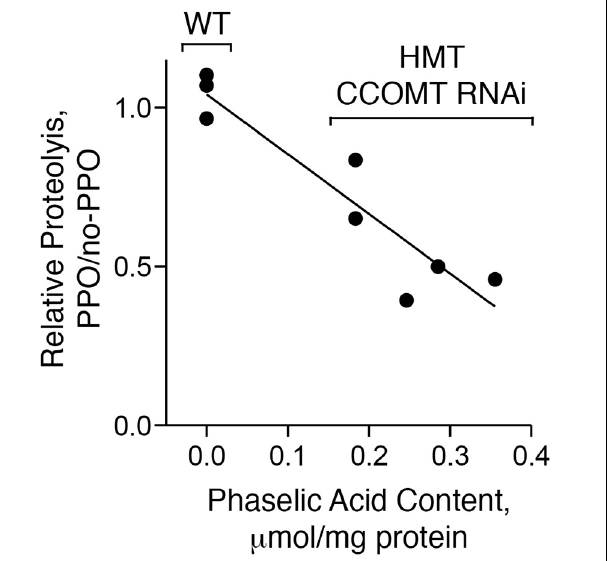
FIGURE 7 | PPO-dependent proteolytic inhibition is correlated with caffeoyl-malate content. Extracts of five transgenic (HMT and CCOMT RNAi) and three wild type plants (WT) were analyzed for caffeoyl-malate content and PPO-dependent proteolytic inhibition. Correlation of PPO-dependent proteolytic inhibition with caffeoyl-malate content was assessed by regression analysis. For the wild type plants, only the median value of the three plants assayed was included in the regression